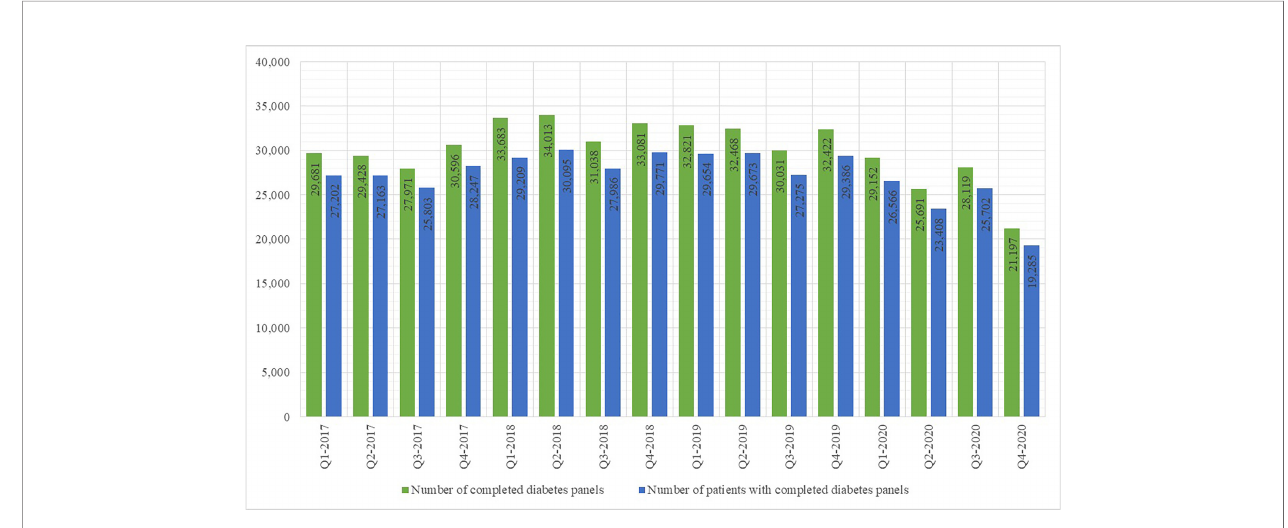
FIGURE 1 | Number of completed diabetes control panels and patients with completed diabetes control panels per yearly quarter 2017 -